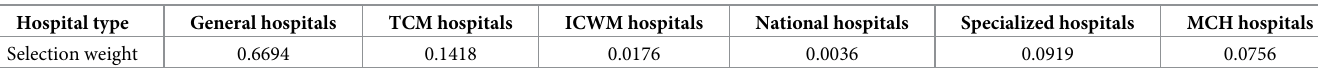
Table 2. The selection probability of each type